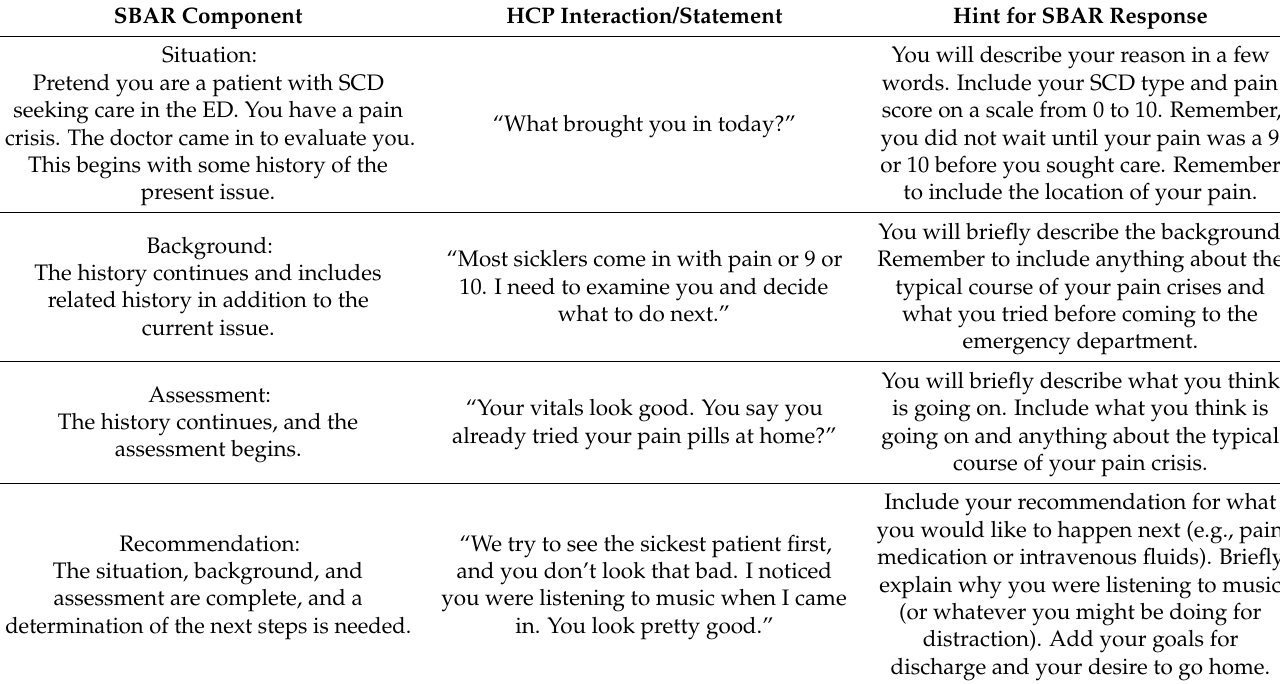
Table 1. SBAR Prompts and